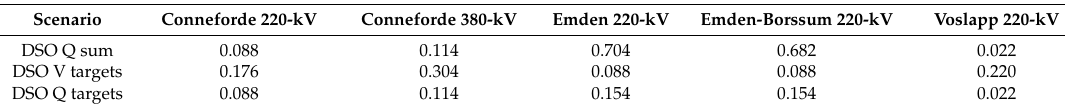
Table 3. Absolute average voltage error at each CP